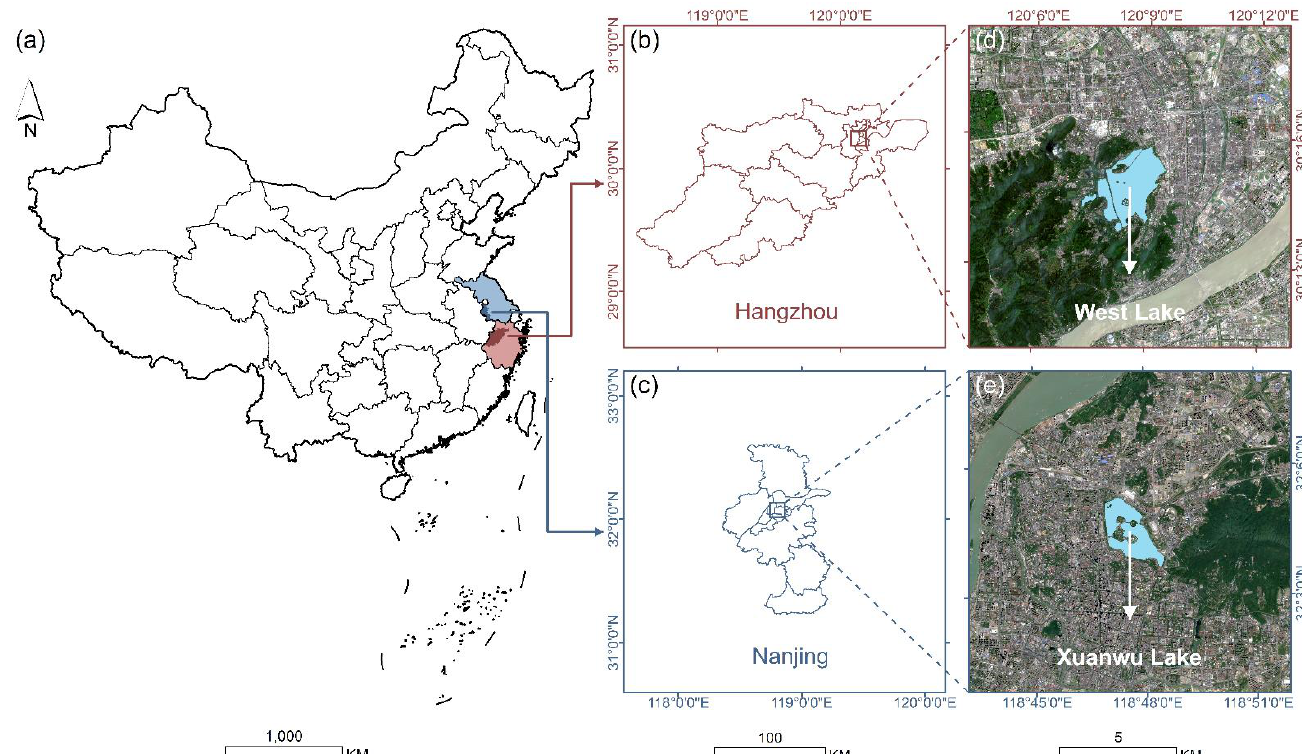
Figure 1. Location of the study area. ( a ) Map of China; ( b ) map of Hangzhou; ( c ) map of Nanjing; ( d ) Sentinel-2 image of West Lake and its neighboring areas; and ( e ) Sentinel-2 image of Xuanwu Lake and its neighboring areas. The sentinel-2 images were displayed in true color composite (Red—Band 4; Green—Band 3; and Bule—Band